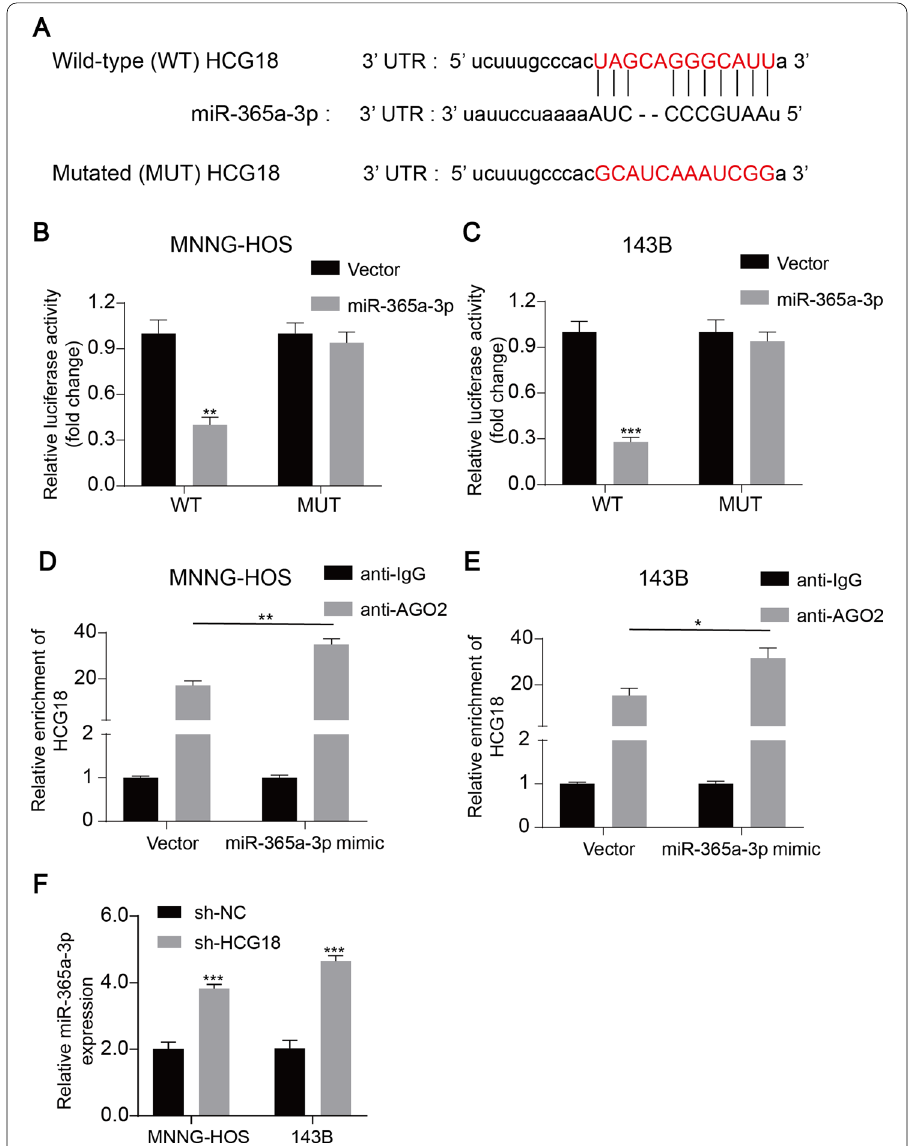
Fig. 5 HCG18 acted as a molecular sponge of miR-365a-3p. A Putative binding sites between HCG18 and miR-365a-3p. B and C Luciferase activity of OS cells in luciferase reporter plasmid containing wild-type